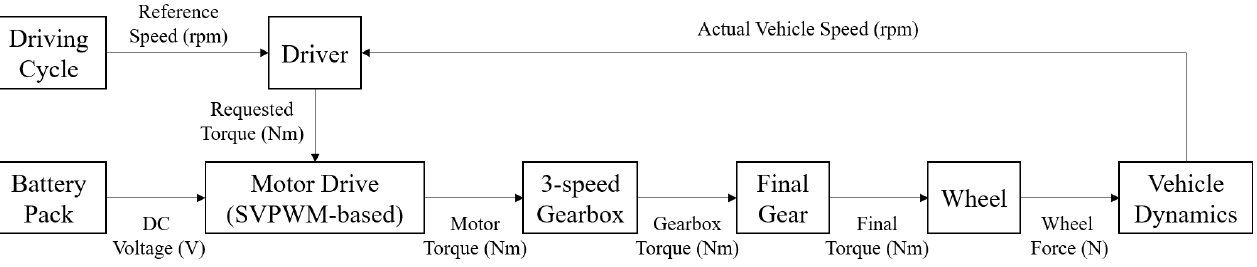
Figure 20. Overall block diagram for the dynamic model used in HDT simulation. Table 9. Specification of the Class-7 Electric Truck Model. Data from [3].